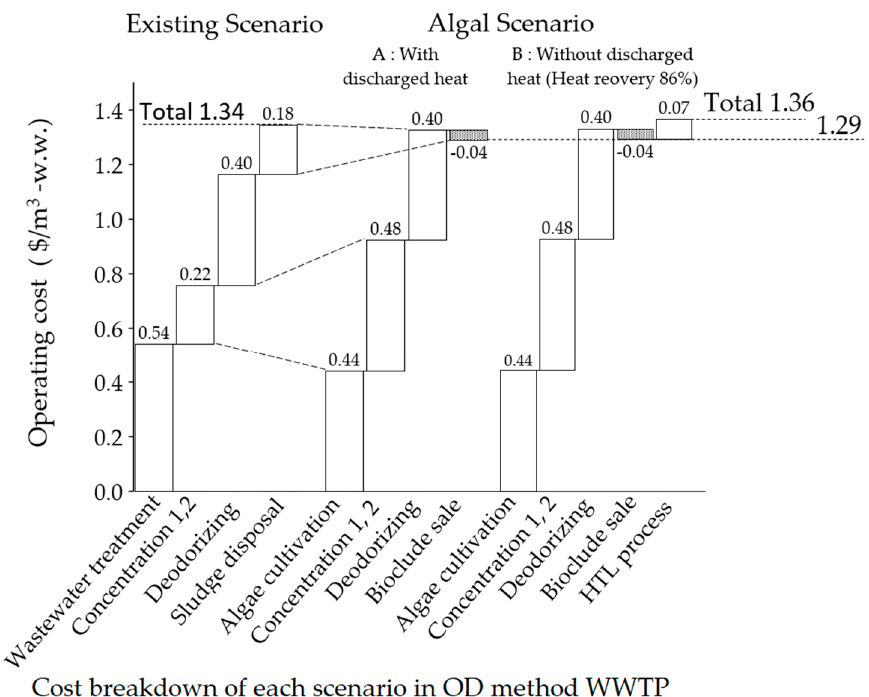
Figure 10. Operating costs ($: USD) per 1 m 3 -w.w. for existing and microalgae oil production scenarios A and B (Treatment volume is 81.6 m 3 -w.w./d).